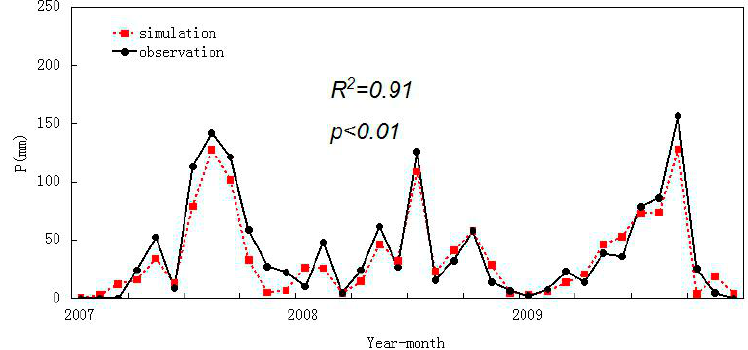
Figure 6. Comparison of simulated and observed monthly precipitation ( P ) at Camp ‐ AWS from 2007 to 2009.